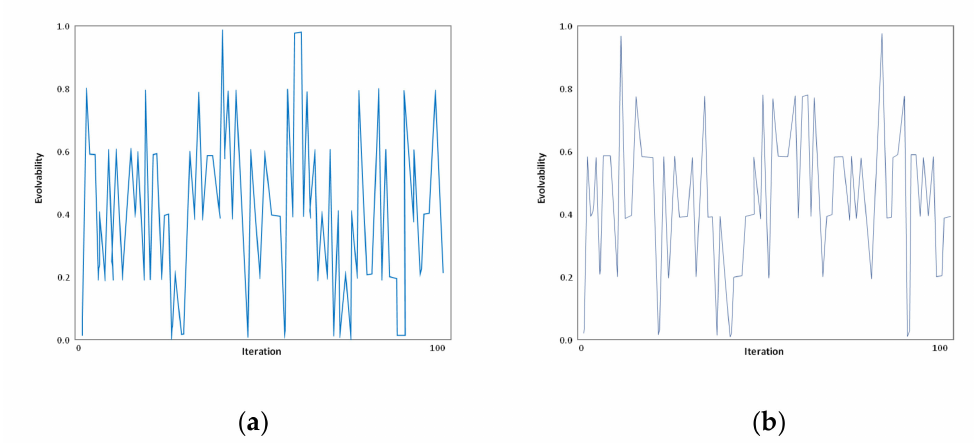
Figure 18. The evolvability along the iterations in case of 2-opt ( a ) and order crossover operator ( b